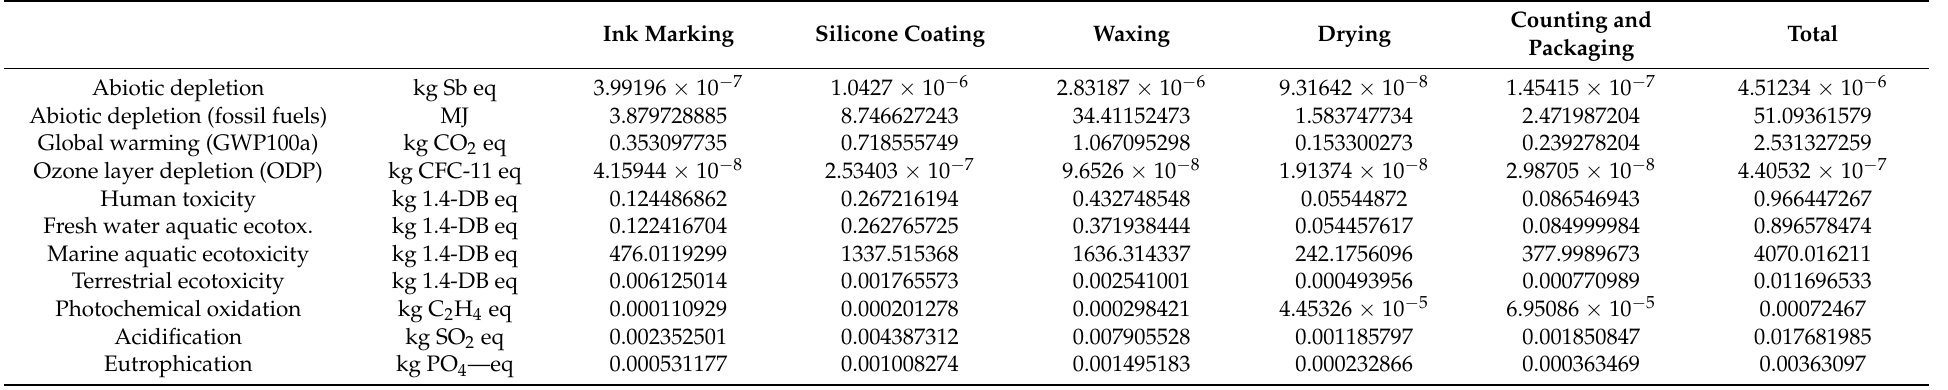
Table 14. Impact of stage 3 broken down by activities for the manufacturing process of perforated stoppers of 2-pieces of 24 mm in diameter and 44 mm in length. Ink Marking Silicone Coating Waxing Drying